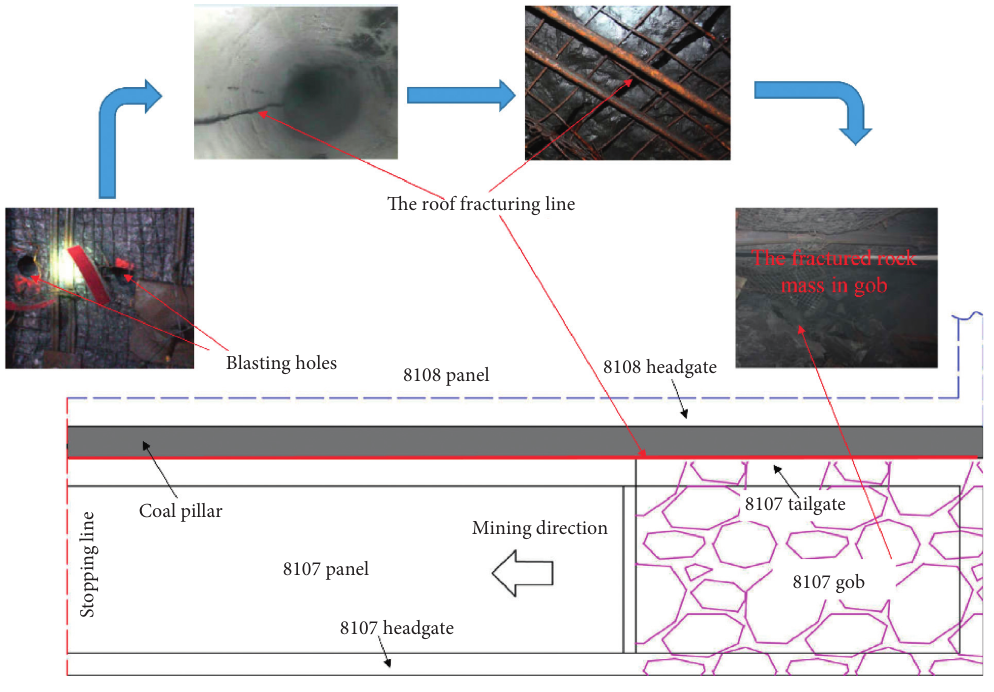
Figure 18: Exhibition of roof fracturing and rock mass filling.